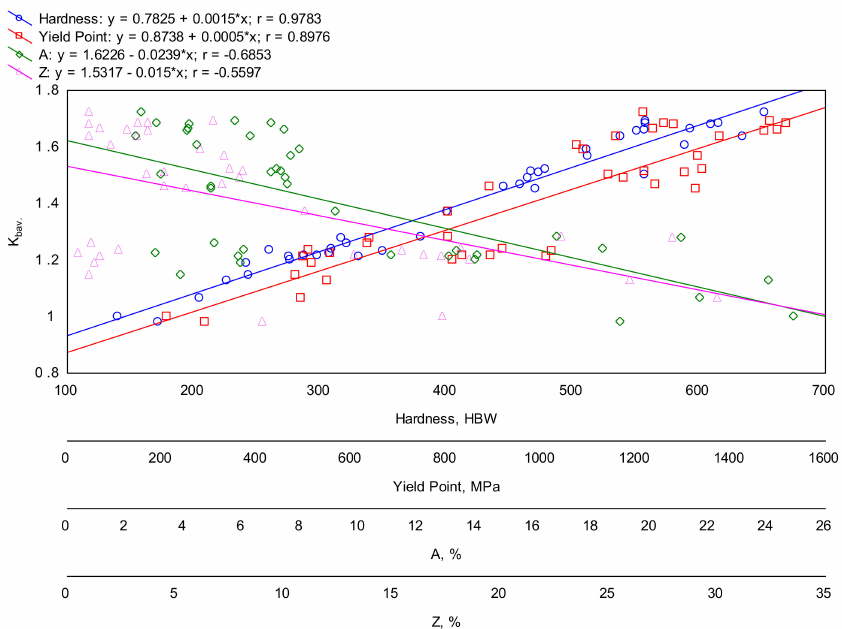
Figure 19. Correlations between the abrasive wear resistance index K b and the hardness, yield point, elongation and area reduction after fracture of the ingots in all the considered states (as-cast, quenched, quenched and tempered at 200, 400 and 600 ◦